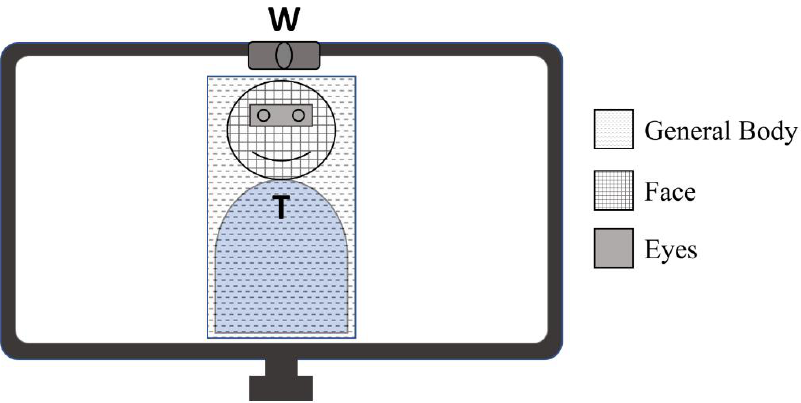
Figure 2. The delineation of the eyes , face , and general body regions of interest included in the on- screen portion of the visual scene from the client perspective. Legend: T: Therapist. W: Webcam.